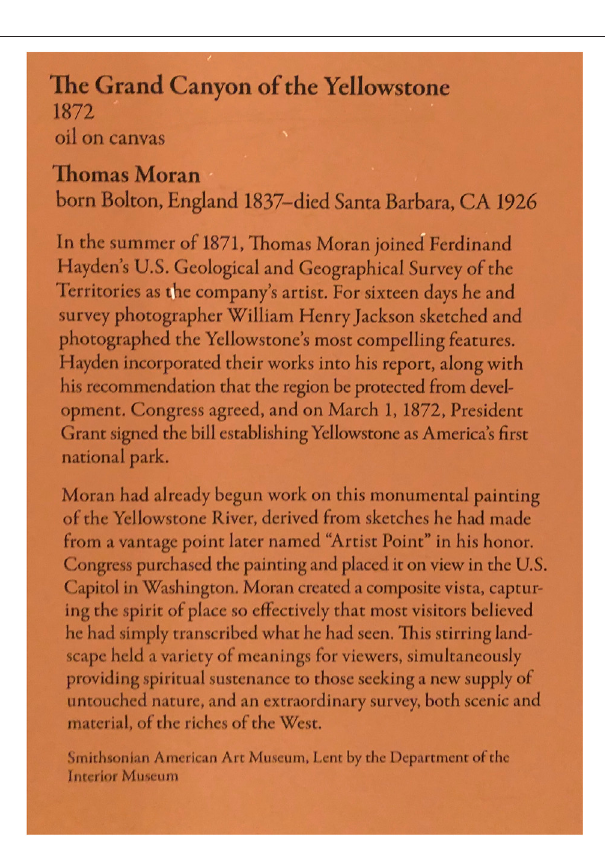
FIGURE 6 | Placard accompanying Thomas Moran ’ s Grand Canyon of the Yellowstone at the Smithsonian Art Museum. Author Photograph,